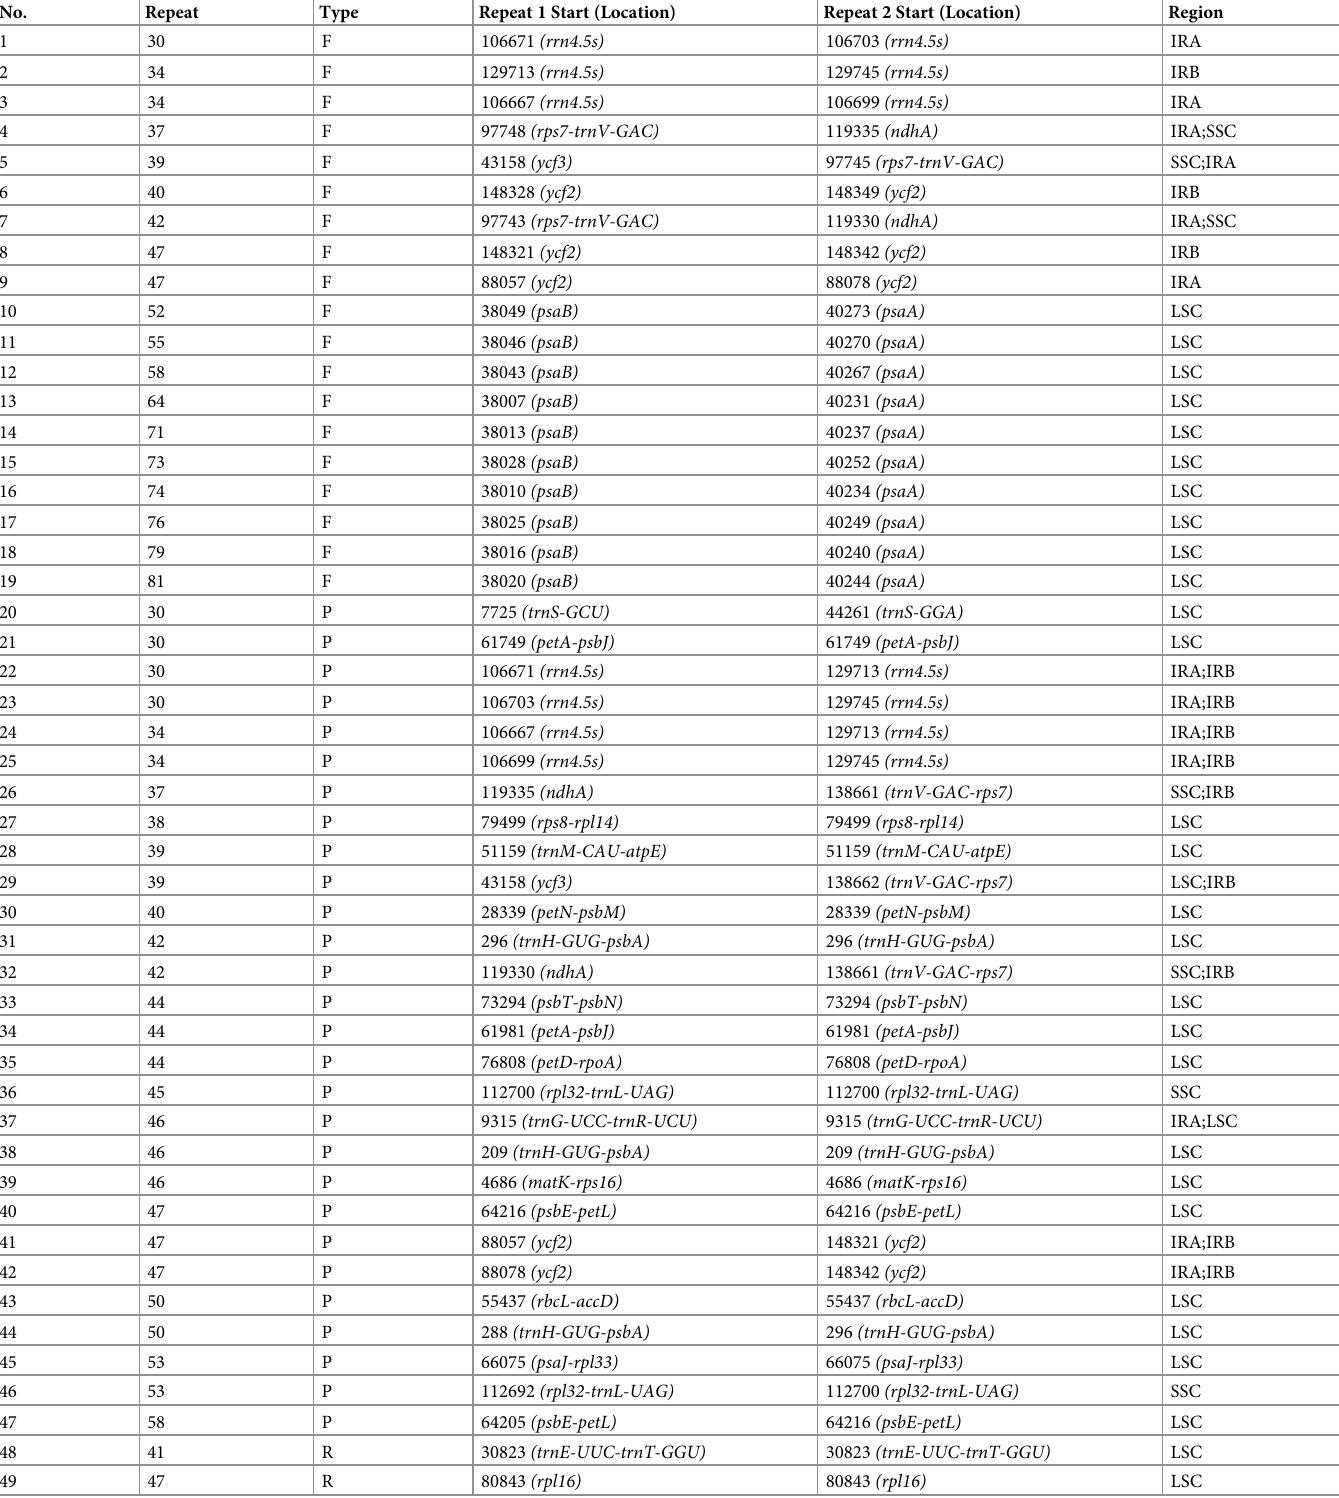
Table 3. Repeat sequences in the Moricandia arvensis cp genome.